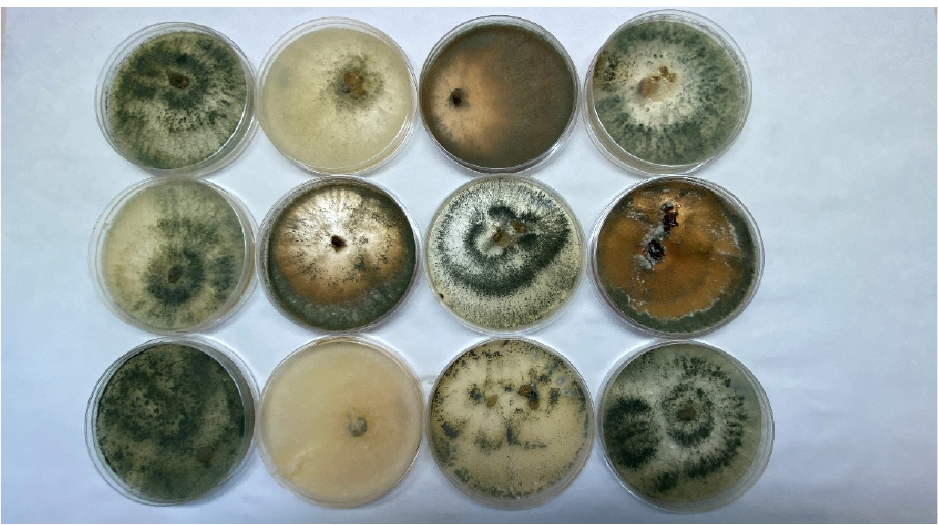
Figure 1. Colonies of fungi of the Trichoderma